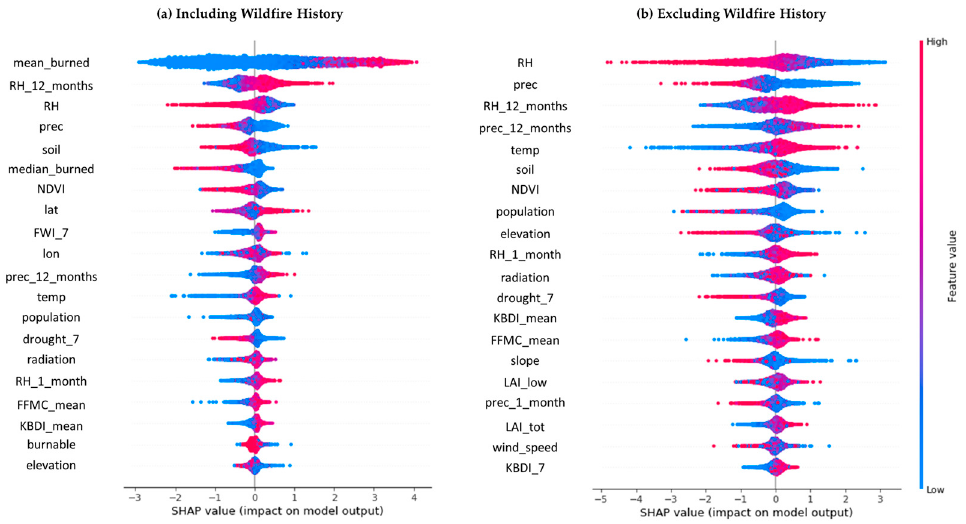
Figure 6. Feature importance by model—wildfire occurrence classification. Feature importance plot for the highest performance model—XGBoost.